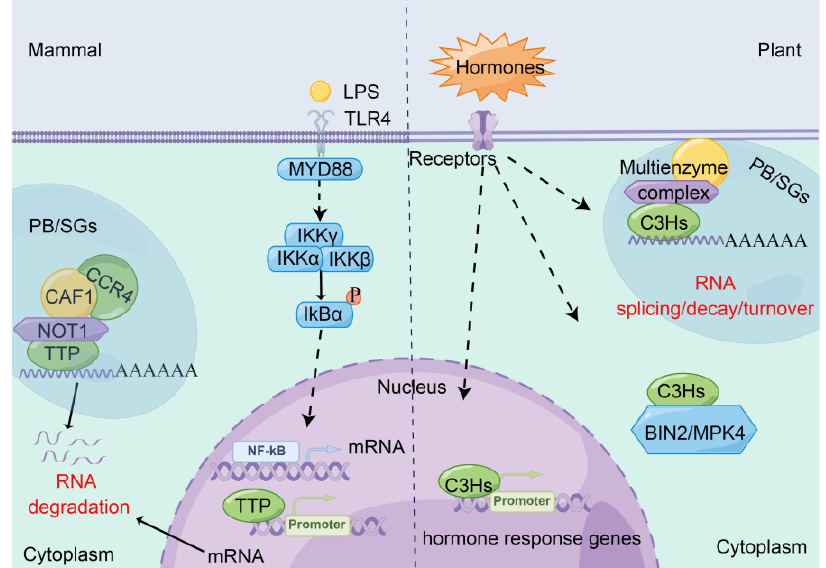
Figure 5. Regulatory mechanism models of plant and animal CCCH proteins involving in hormone signal transduction. Left panel: In mammals, lipopolysaccharide (LPS) recognizes Toll-like receptor 4 (TLR4), which activates the Nuclear Factor- κ B (NF- κ B) kinase complexes (IKK α , IKK β and IKK γ ), resulting in the phosphorylation and degradation of IkBa. The released NF- κ B translocates into the nucleus and activates the expression of genes, such as tristetraprolin (TTP) and tumour necrosis factor (TNF). TTP further binds to AU-rich elements (AREs) in the 3 (cid:48) UTR of TNF mRNAs and promotes mRNA decay by recruiting the CCR4 − CAF1 − NOT1 deadenylase complex in processing bodies (PBs) or stress granules (SGs). In addition, TTP performs transcriptional regulation. Right panel: In Arabidopsis, multiple hormones recognize the corresponding receptors, activating a serials of signal cascade reactions and inducing transcriptional regulation of AtC3H14 and 15 (the homologs of TTP) in nucleus. AtC3H14 and 15 not only interact with different types of proteins, such as MAP kinase 4 (MPK4) and BR-INSENSITIVE 2 (BIN2) in signal transduction, but also perform post-transcriptional regulation in PBs and